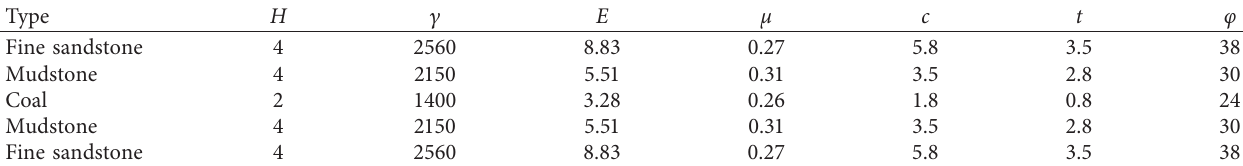
Figure 2: The FLAC 3D numerical simulation model. Table 2: Rock mechanics